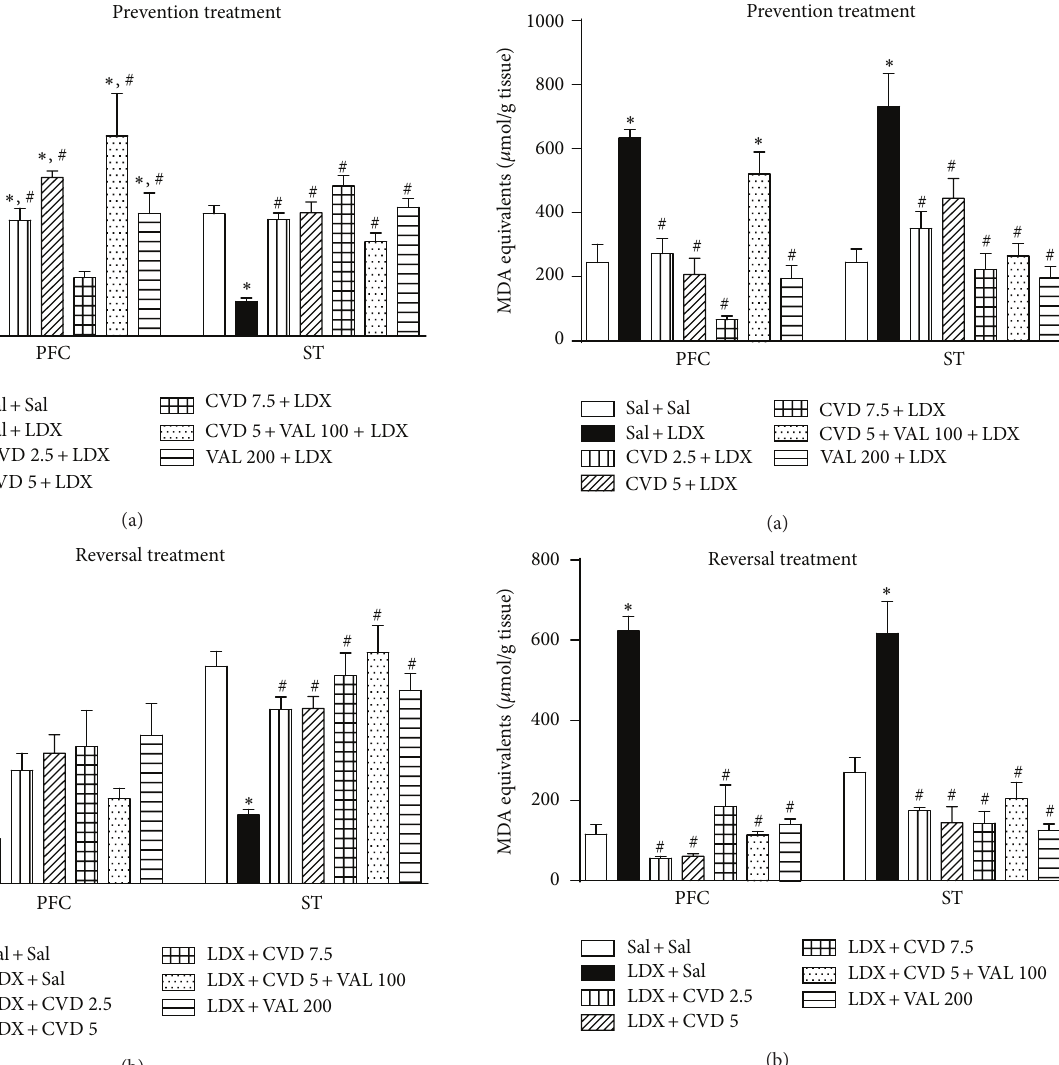
Figure 4: Levels of reduced glutathione (GSH) in the prefrontal cortex (PFC) and striatum (ST) of mice submitted to the prevention (a) and reversal (b) treatments. Data were analyzed by one-way ANOVA followed by Student-Newman-Keuls post hoc test. Values are expressed as mean ± SEM (6–8 animals/group). ∗ 𝑃 < 0.05 versus Sal + Sal; # 𝑃 < 0.05 versus Sal + LDX or LDX + LDX. CVD: carvedilol; LDX: lisdexamfetamine; Sal: saline; VAL: valproate.